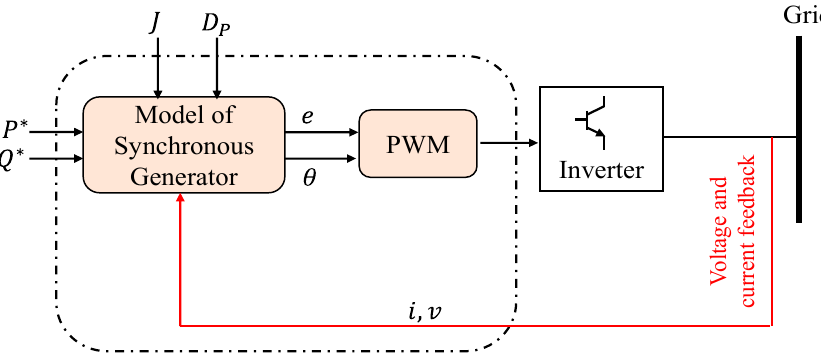
Figure 5. Synchronverter topology overall schematic showing the operating principle [18].